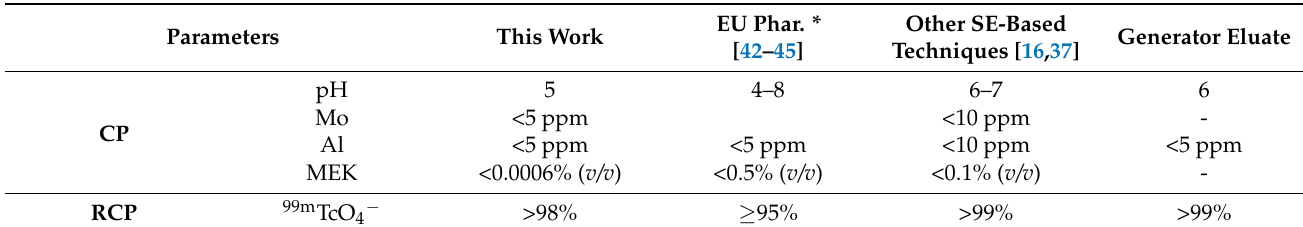
Table 2. CP and RCP of [ 99m Tc]TcO 4 − obtained at the end of the overall procedure of this work compared with the European pharmacopeia requirements for injection, other solvent-extraction-based techniques from the literature, and the quality